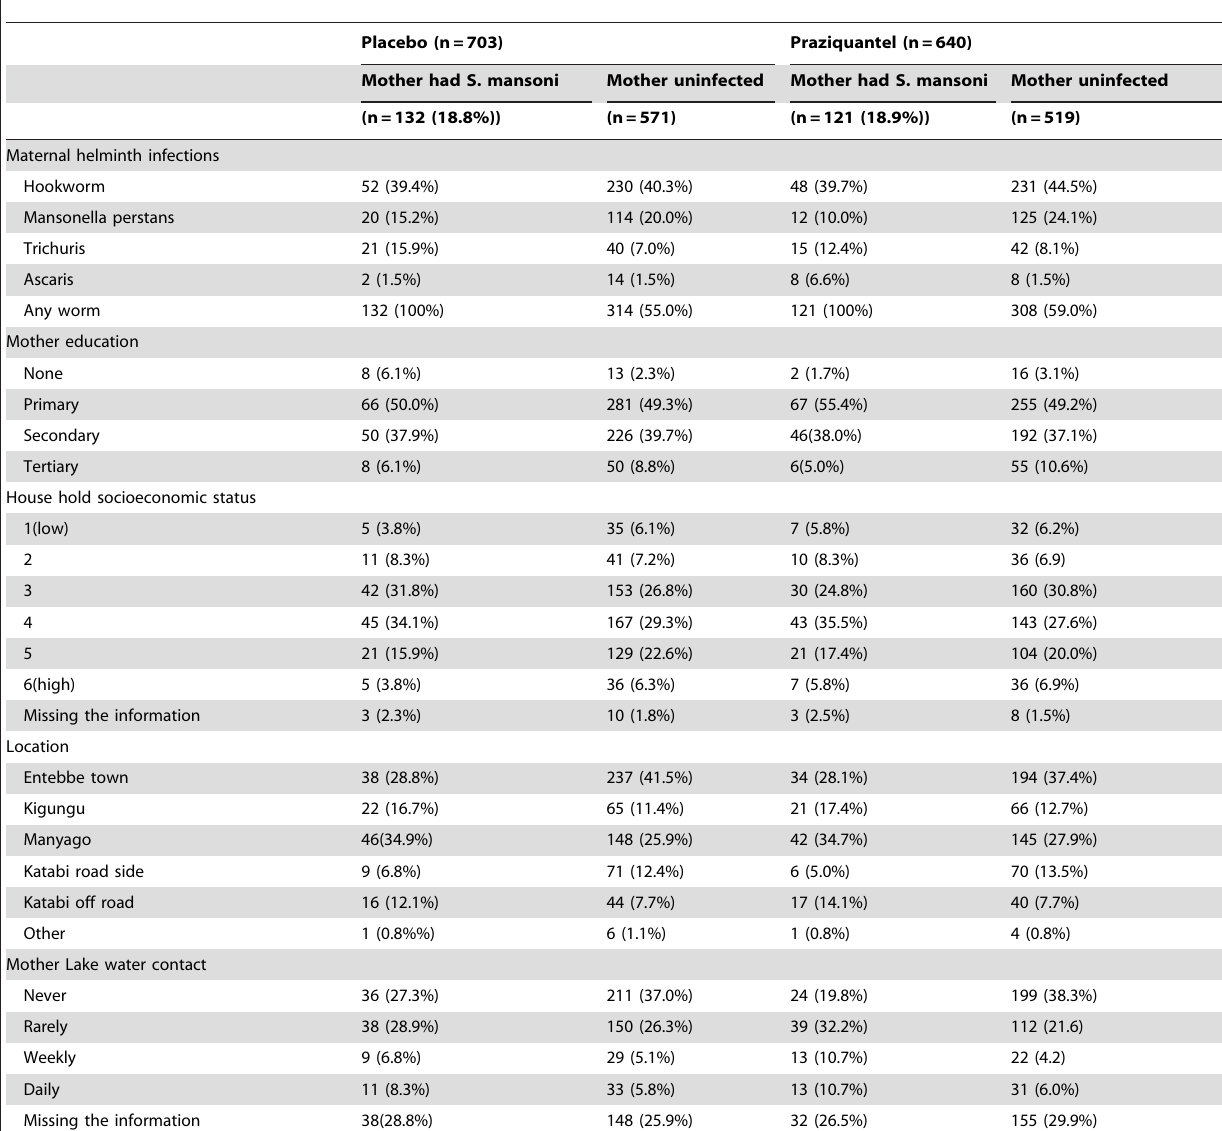
Table 1. Baseline characteristics at enrolment (during pregnancy) for the mothers of the children examined at age 5